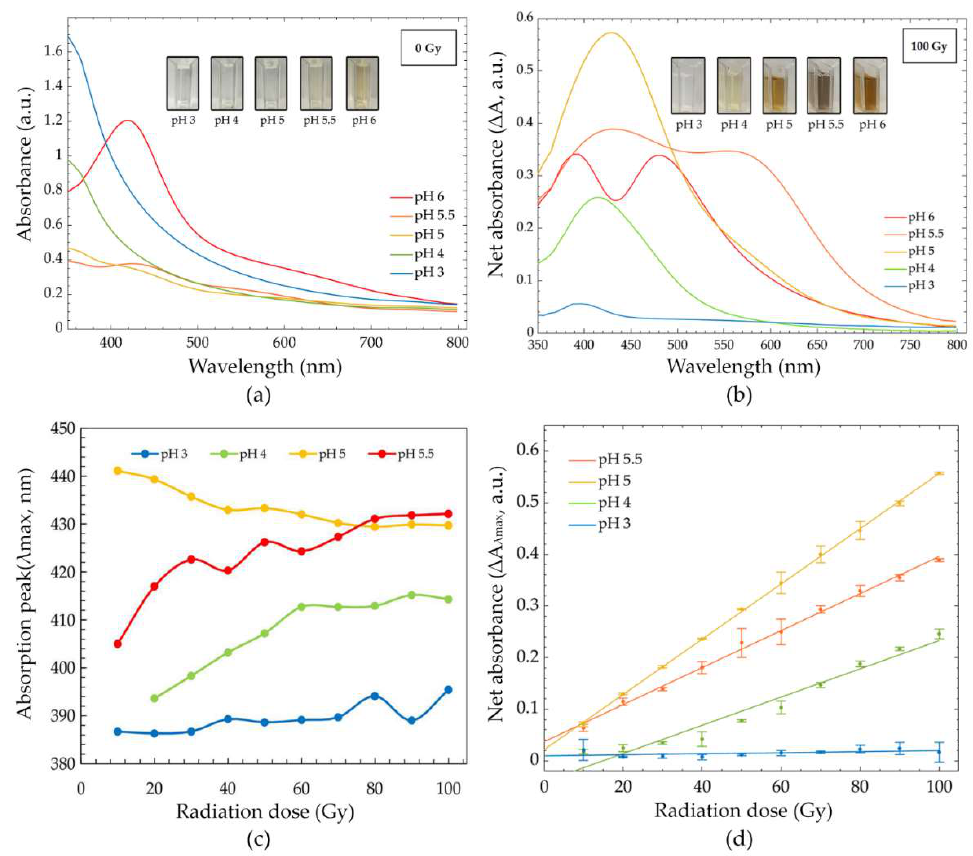
Figure 3. ( a ) Absorption spectra of PVA/AgNPs solution before irradiation (pH 3, 4, 5, 5.5 and 6), ( b ) net absorption spectra after 100 Gy radiation (pH 3, 4, 5, 5.5 and 6), ( c ) absorption peaks ( λ max ) across a range of 0–100 Gy (pH 3, 4, 5 and 6), and ( d ) dose response curves in the range of 0–100 Gy (pH 3, 4, 5, and 5.5).